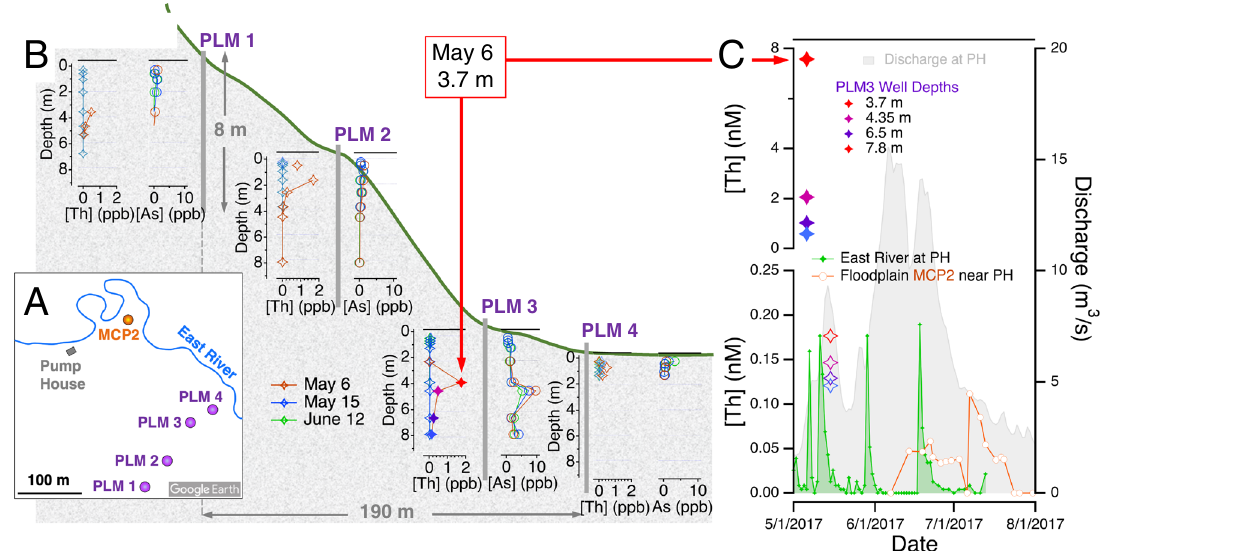
Fig. 3 | Coupled thorium and arsenic excursions observed in deeper ground- water (>3m) but not shallower groundwater in the hillslope or fl oodplain. A Aerial view of Pump House on the East River with locations of monitoring wells PLM1 – 4 and meander piezometer MCP2 indicated. B Depth-resolved thorium and arsenic ground water concentrations measured in PLM wells on 3 days in May and